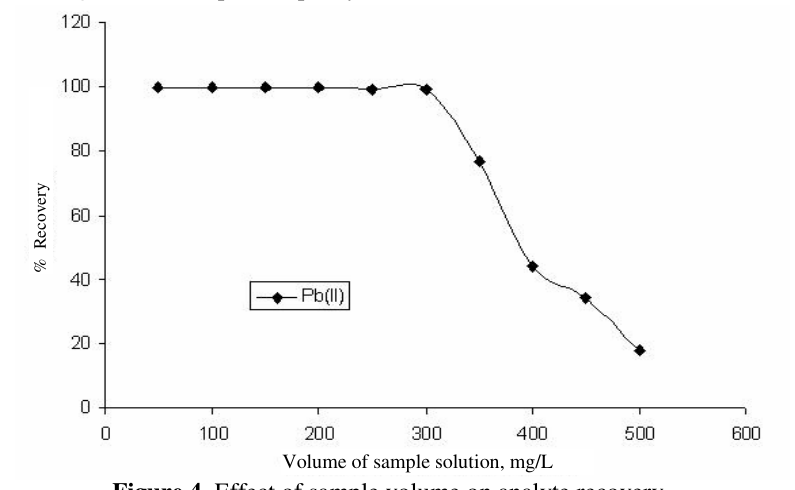
Figure 3. Adsorption capacity of Pb(II) on nanometer SiO